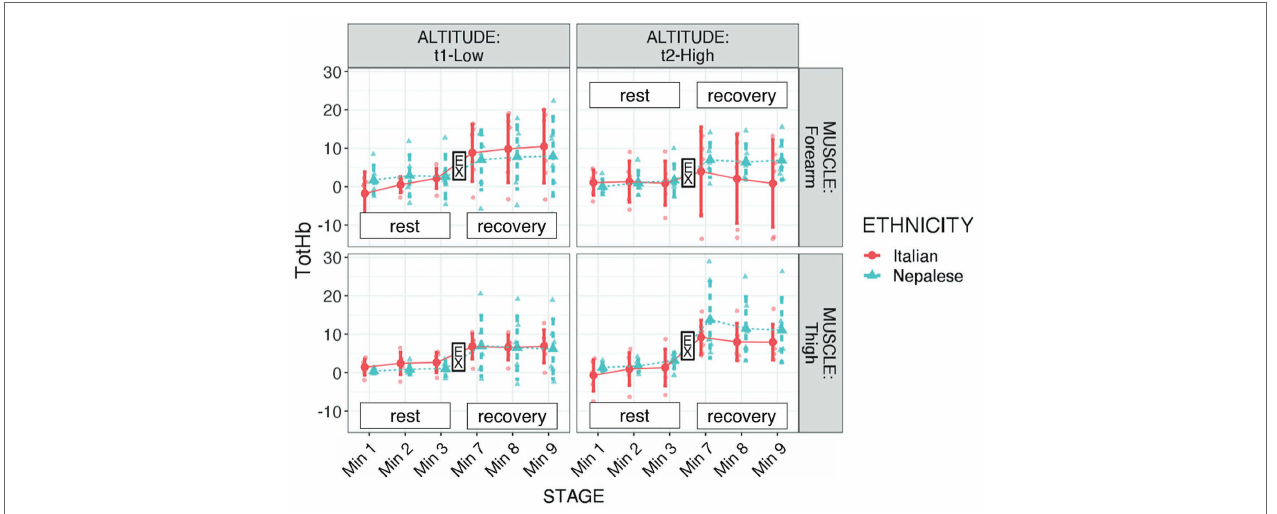
FIGURE 3 | Total hemoglobin (tot-HB) of participants during “Kanchenjunga Exploration & Physiology” project. Measurements were done with a NIRS device on forearm (upper panels) and anterior thigh (lower panels) , 3 min before (rest) and 3 min after (recovery) a 3-min-lasting exercise. Exercise (EX) represents the 3-min time spot of resistance exercise, constituted by 18 submaximal contractions. Both groups (Italians and Nepalese) were measured at low (1,450 m, left panels ) and high (4,750 m, right panels ) altitude. Data represent single values with mean ± SD, averaged by 1-min recording.